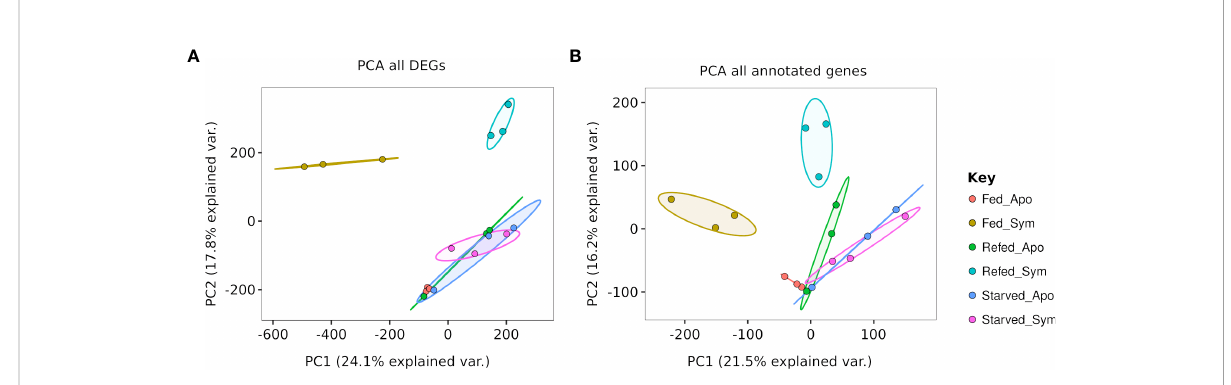
(Supplementary Figure 2). No signi fi cantly enriched GO terms could be found for starved